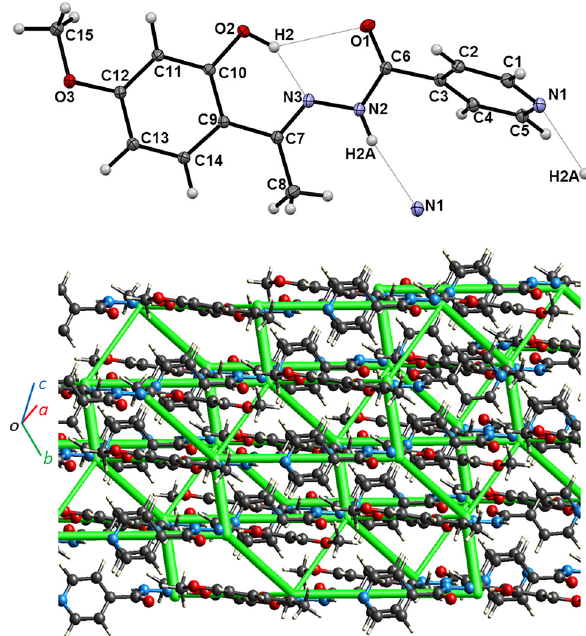
Table  : Data collection and